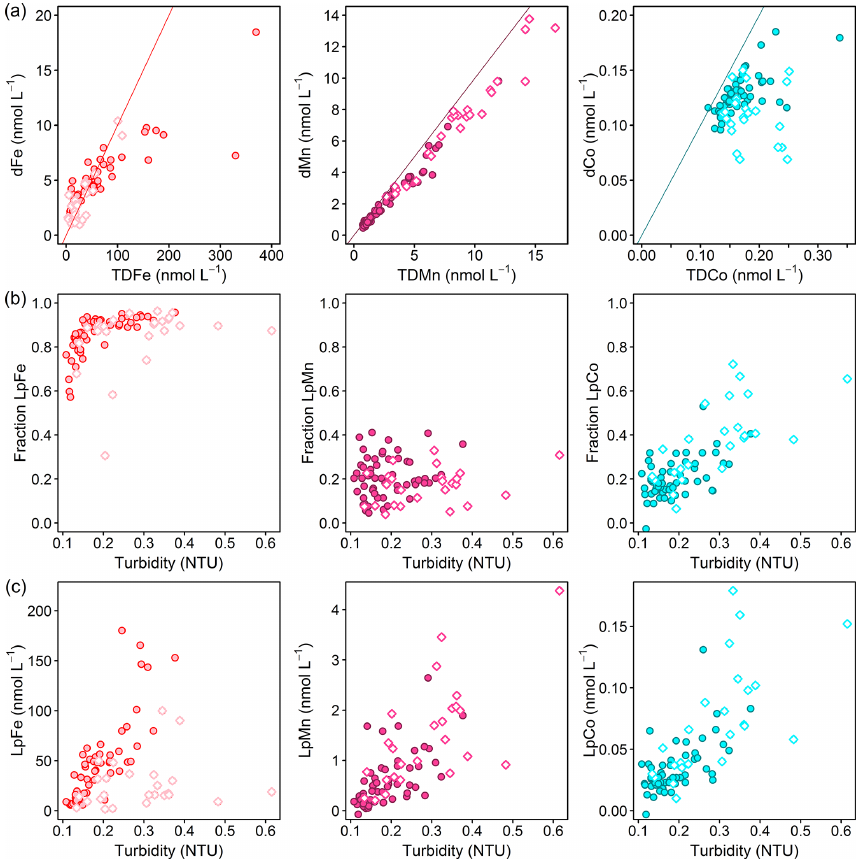
Figure 6. (a) Dissolved against total dissolvable trace-metal concentrations for Fe (left; red line: TDFe = 10 · dFe), Mn (middle; purple line: TDMn = dMn), and Co (right; turquoise line: TDCo = dCo). (b) Fraction of leachable particulate trace metals (Lp / TD) against turbidity and (c) leachable particulate concentrations against turbidity for Fe (left), Mn (middle), and Co (right). Filled circles display all data points below 50m depth and open diamonds at depths shallower than